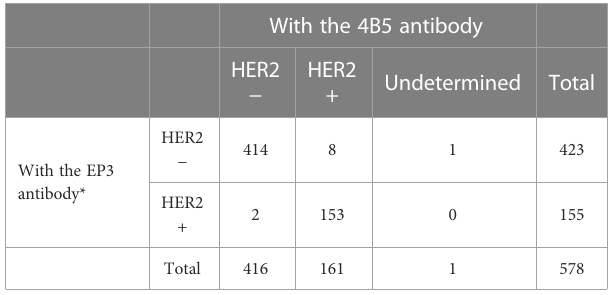
TABLE 1 Comparison of dichotomized QDB results measured with 4B5 and EP3 using their respective cutoffs in the merged cohort (cohorts 1 and 2; n = 578).